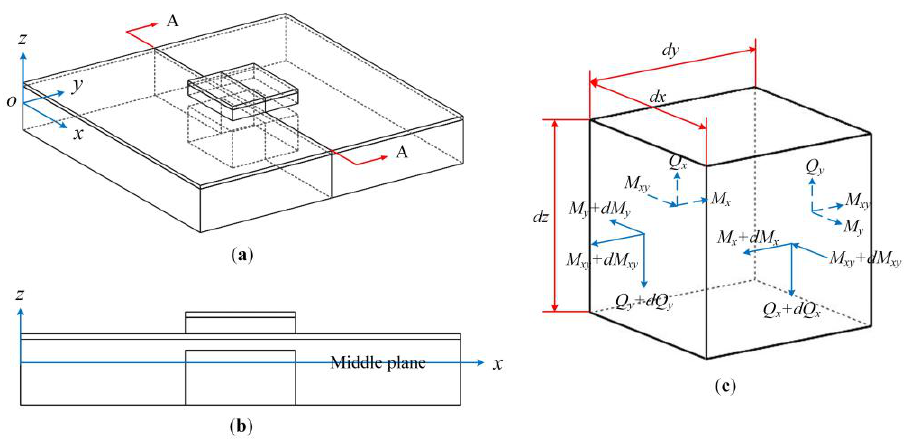
Figure 3. ( a ) The geometry of the single-element DFUT structure; ( b ) the cross-sectional view; ( c ) resultant forces and moments for one finite element. Table 1. Structural parameters of the single-element DFUT in the glossary of symbols. Structural Parameter